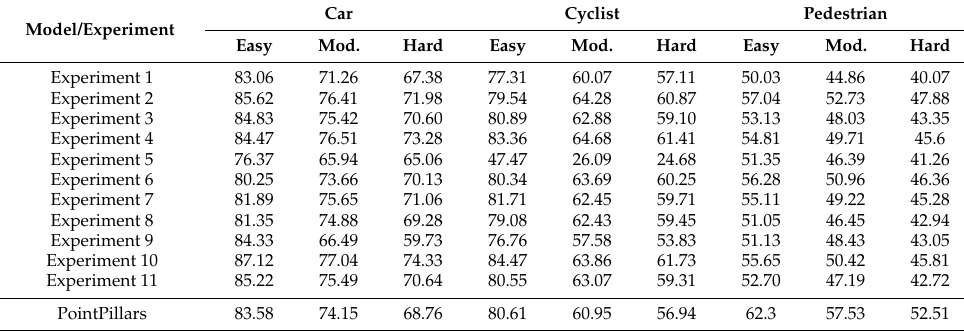
Table 8. Results in validation set for 3D Bounding Box detection metric.